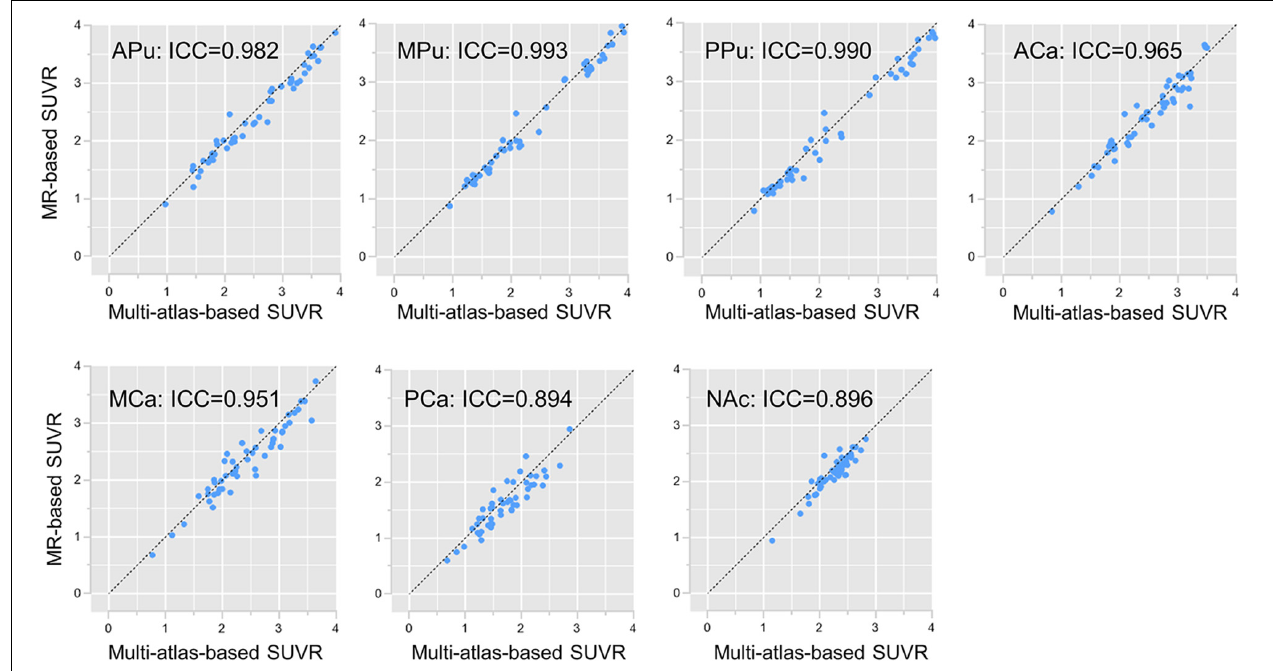
FIGURE 4 | Subregion SUVR correlations. Subregion SUVR correlations between the multi-atlas-based PET segmentation and the MR-based segmentation in cohort UI. The horizontal axis is the SUVR of each subregion separated by the multi-atlas-based PET segmentation, whereas the vertical axis is the SUVR of each subregion separated by the MR-based